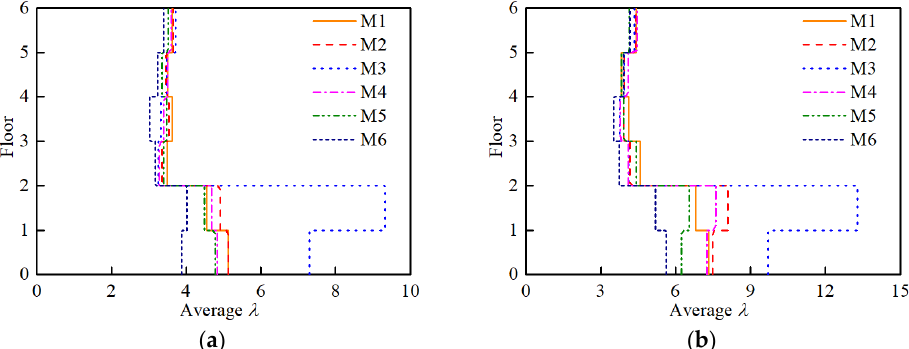
Figure 14. The average 𝜆 of floors along the slope direction: ( a ) a PG, x = 0.4 g; ( b ) a PG, x = 0.62 g.